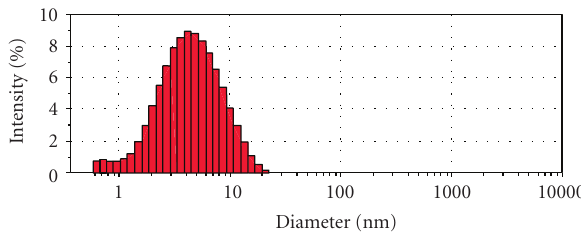
Figure 2: Colloidal nanoparticle size distribution before hydrother- mal treatment.